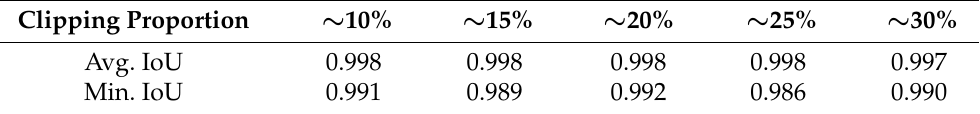
Table 4. Image alignment results according to clipping proportions.